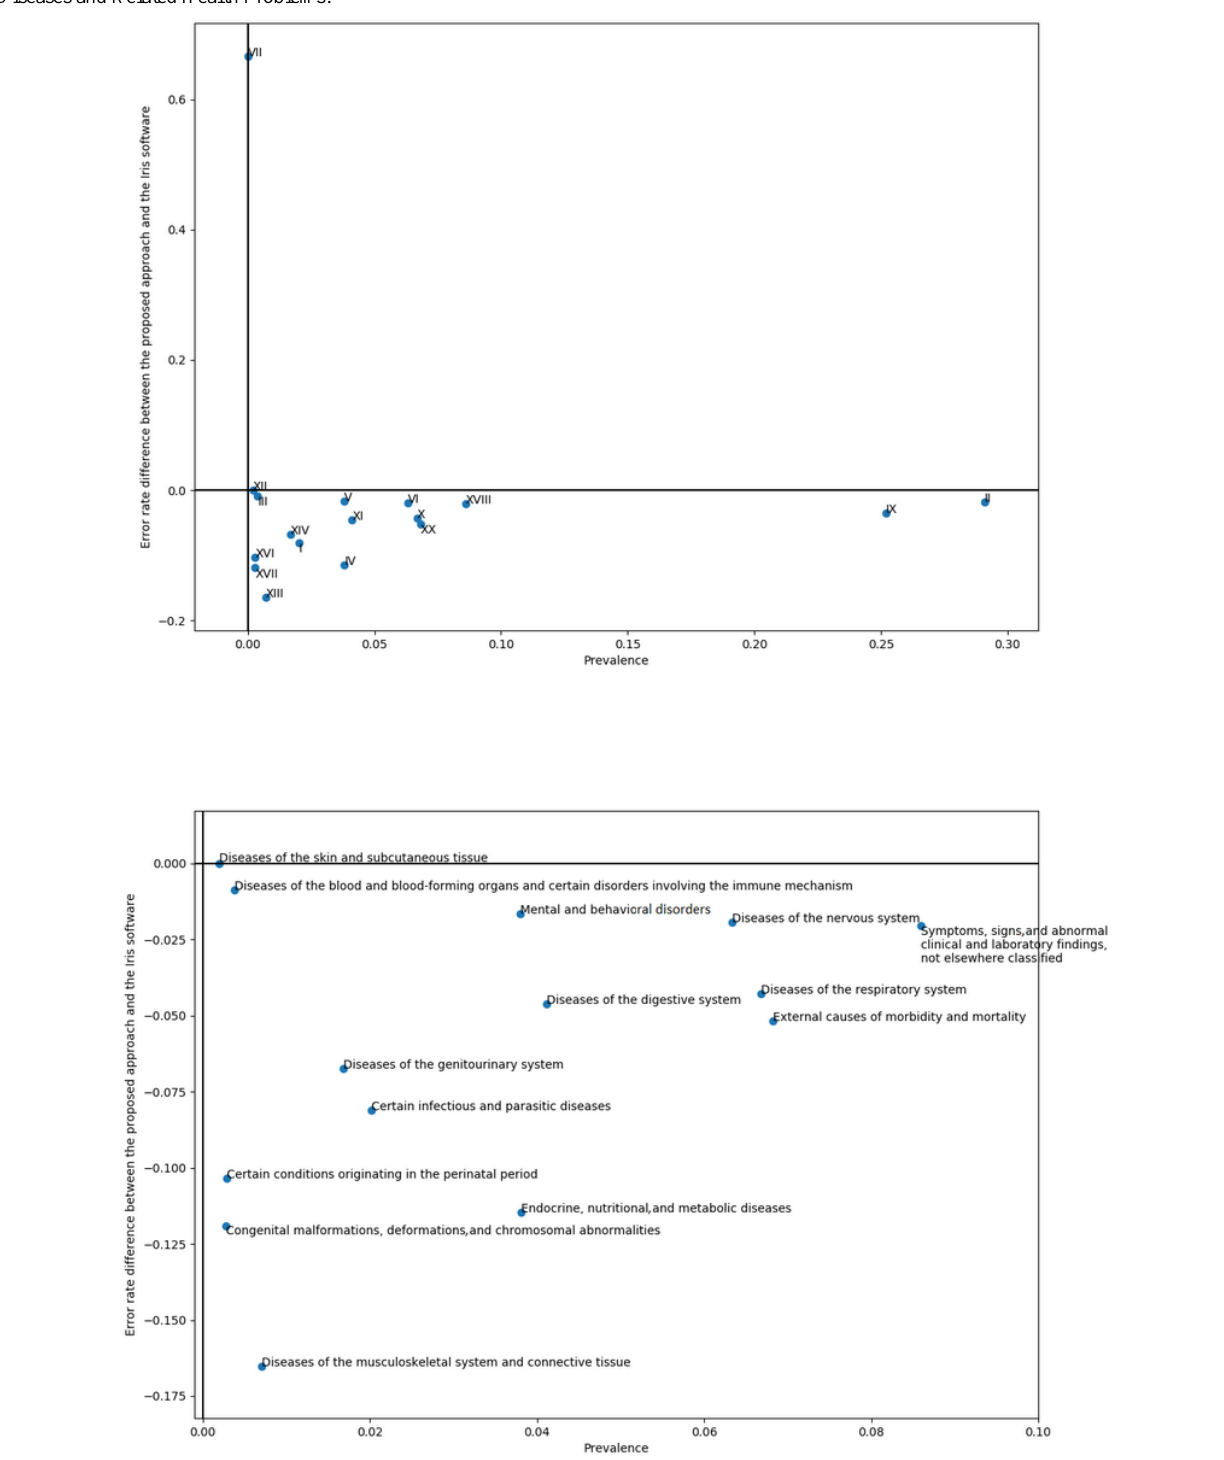
Figure 5. The top plot shows the difference in error rate between the proposed model and the Iris software versus ICD-10−chapter prevalence as underlying cause. The bottom plot is a zoom on the top plot’s bottom left-hand corner. ICD-10: 10th revision of the International Statistical Classification of Diseases and Related Health